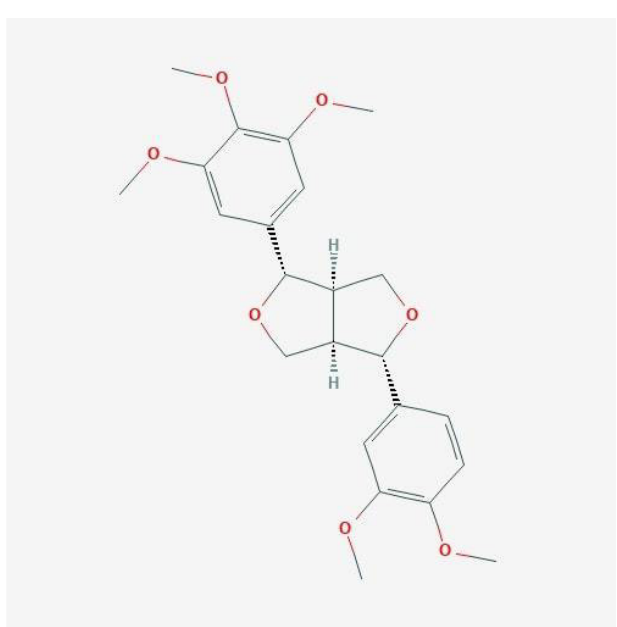
FIGURE 1C - Magnolin is a natural compound abundantly found in Magnolia flos, which has been traditionally used in oriental medicine to treat headaches, nasal congestion and anti-inflammatory reactions.